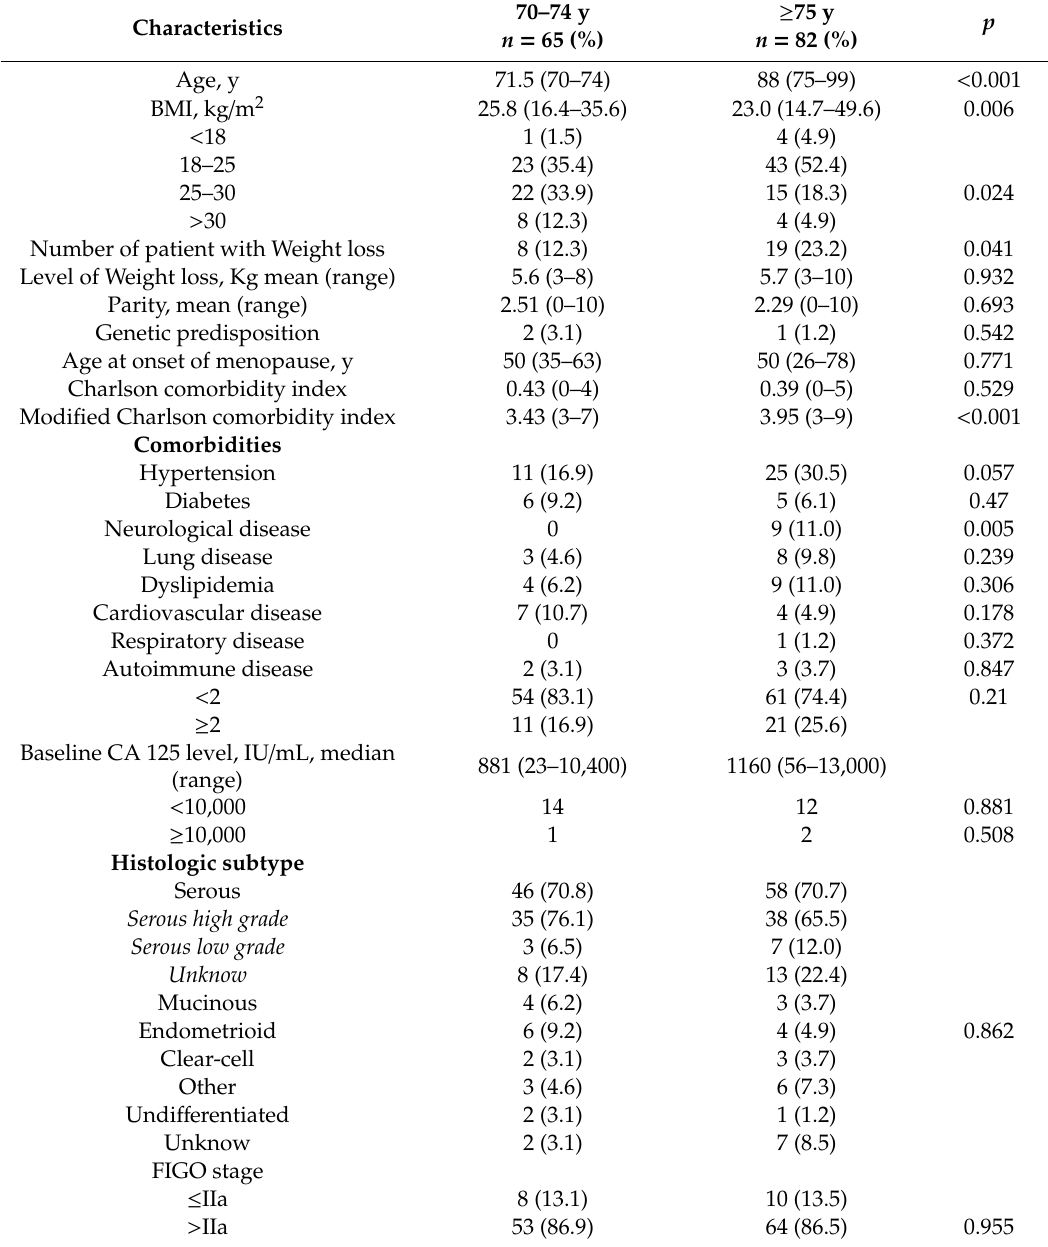
Abbreviations: FIGO, International Federation of Gynecology and Obstetrics; BMI, Body Mass Index; a data expressed as n (%) or median (range) unless otherwise